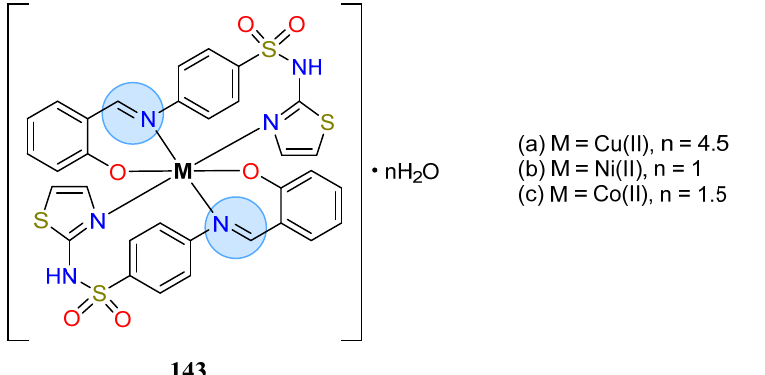
Figure 69. Ni(II), Cu(II), and Co(II) complexes containing a tridentate Schiff base (ONN) based on sulfathiazole studied for their antimicrobial activity.